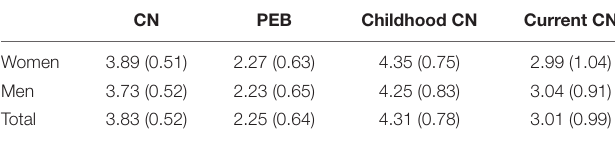
TABLE 1 | Mean values (standard deviation) of connectedness to nature (CN), reported pro-environmental behaviors (PEB), and contact with nature during childhood and currently (childhood CN and current